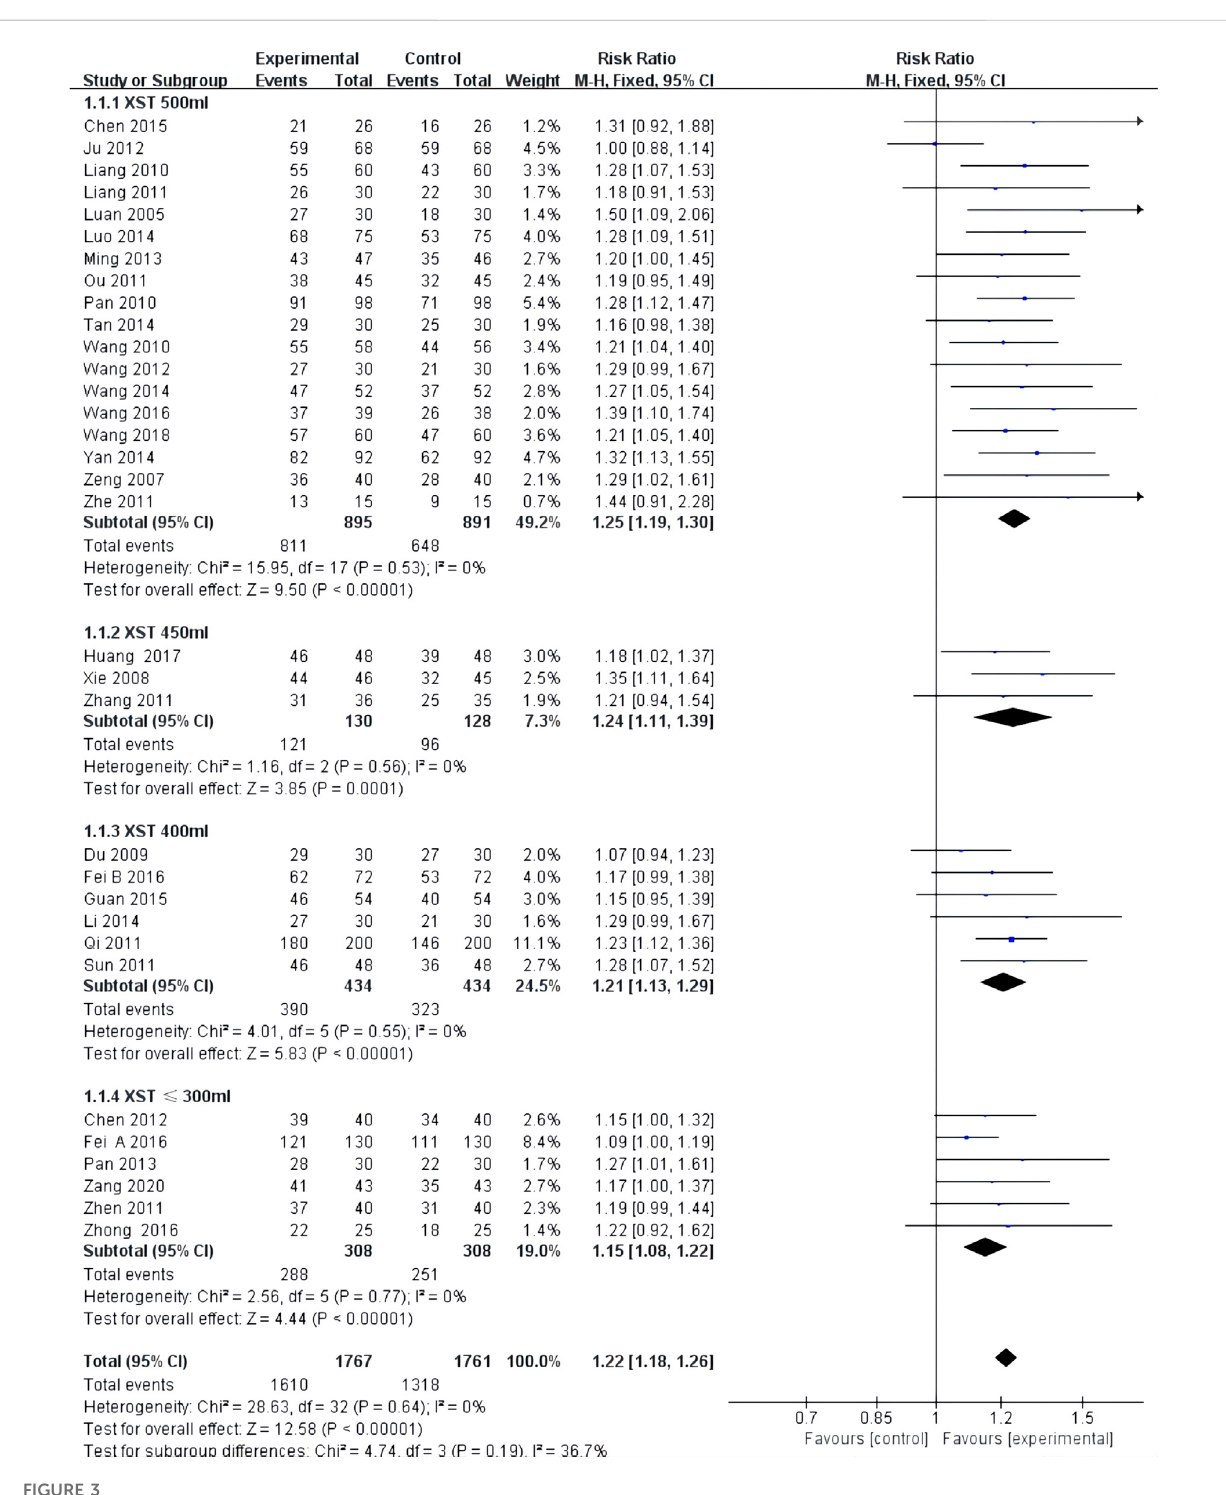
FIGURE 3 Forest plot of clinical comprehensive ef fi